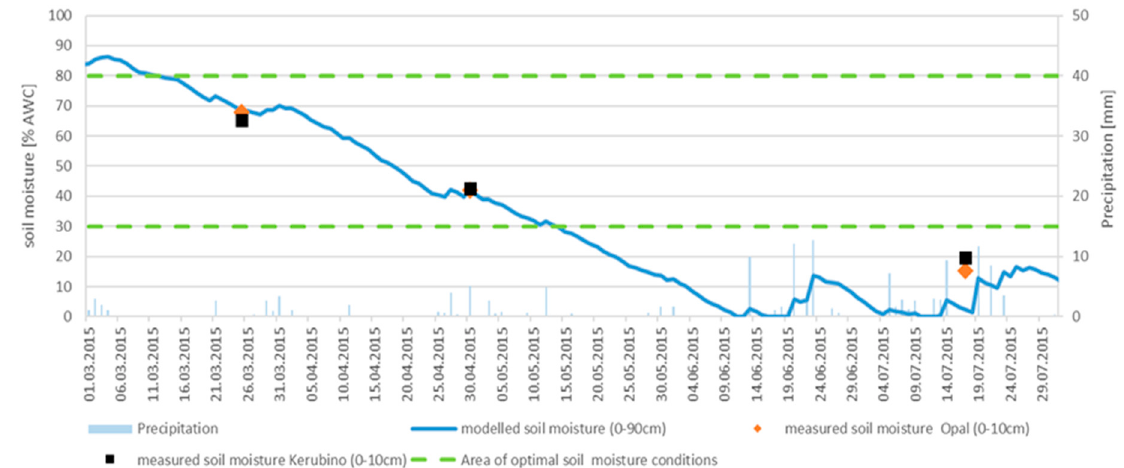
Figure 9. Modeled and measured soil moisture [% AWC] of unirrigated winter wheat plots Opal and Kerubino and precipitation [mm] in the period March to July 2015.